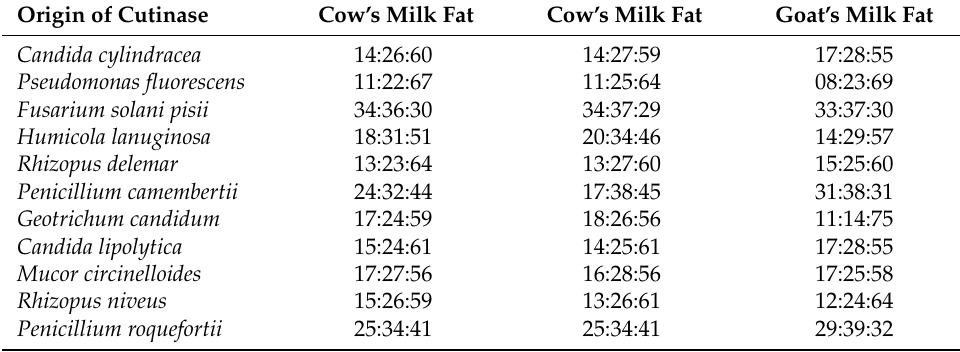
Table 3. Proportions of fatty acids according to the length of their chain in lipolyzed milk fats of cow, sheep and goat. The results are shown as short chain (C4–C8), medium chain (C10–C14) and long chain